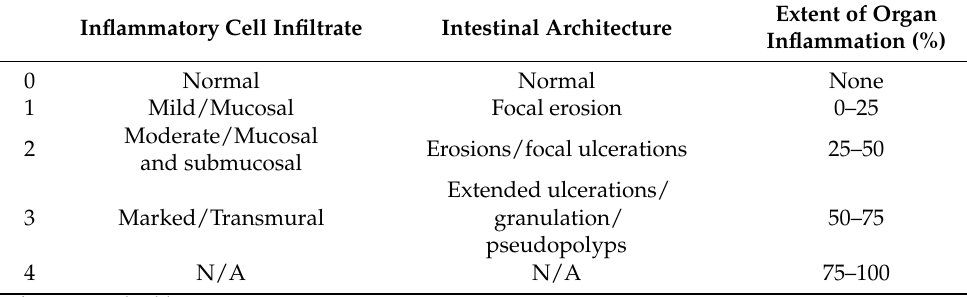
Table 2. Histopathological scoring